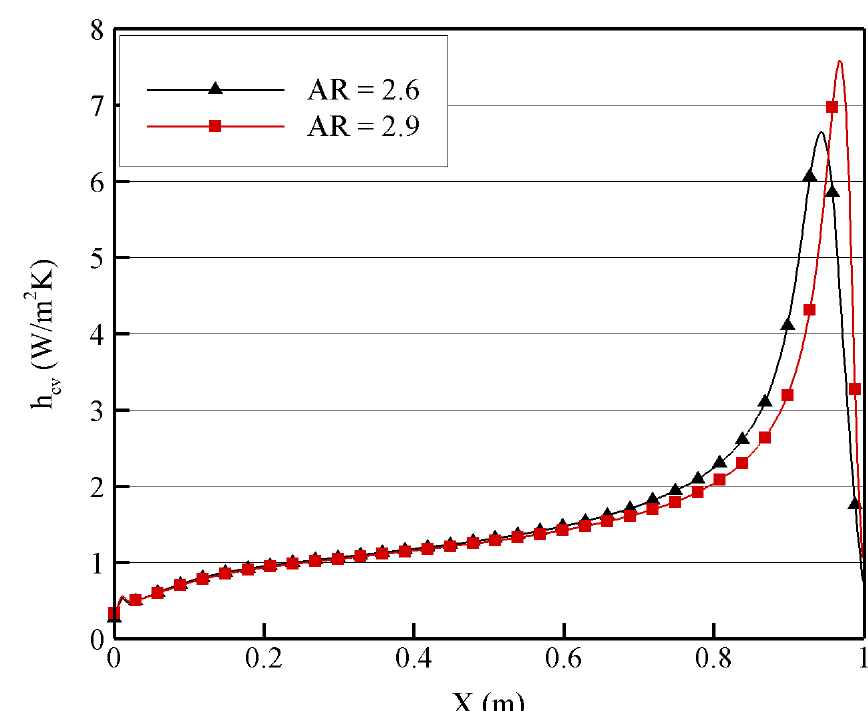
Figure 12. Convective heat transfer coefficient at θ = 30°, AR = 2.6, AR = 2.9.